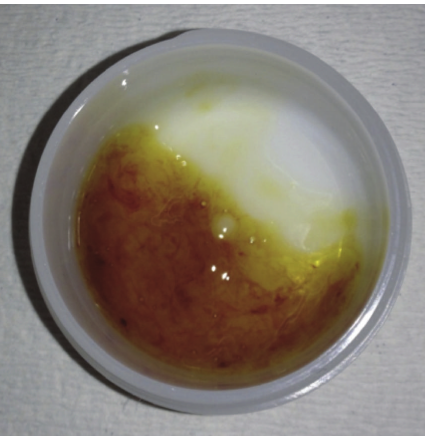
Figure 1: Hematochezia. The patient experienced abdominal pain with frequent hematochezia.